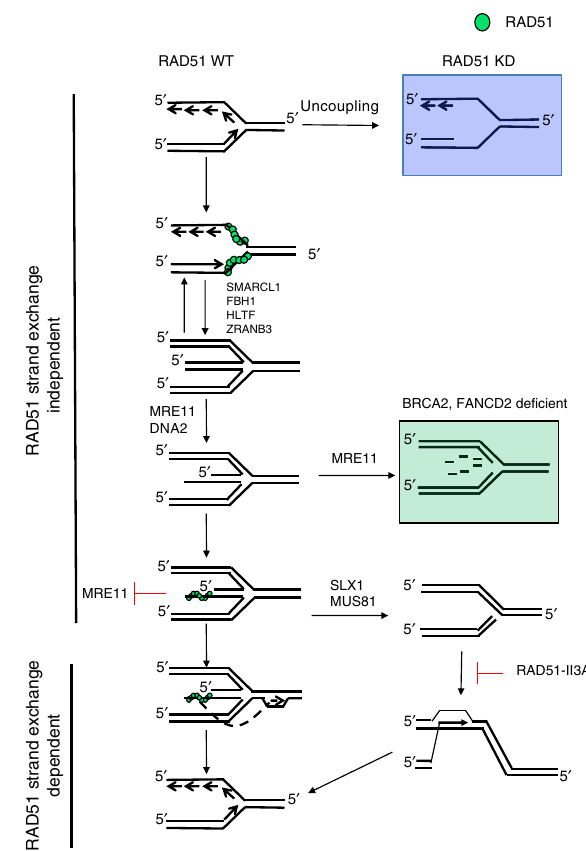
Fig. 6 Model depicting role of RAD51 at stalled replication forks. RAD51 binds to a stalled replication fork and stabilizes it by preventing extensive ssDNA formation. Proteins such as SMARCL1 and FBH1 promote replication fork regression resulting in the formation of the chicken foot structure. DNA2 resects the middle toe providing a substrate for RAD51 strand exchange-dependent fork restart. DNA2 also promotes degradation of nascent strands after fork regression in cells expressing hsRAD51-WT or hsRAD51-II3A (not depicted). In RAD51-depleted cells (RAD51 KD), the replication fork contains excess ssDNA due to uncoupling (Blue Box). hsRAD51-II3A is able to prevent MRE11-degradation by binding directly to the middle toe. hsRAD51-II3A is unable to restart the fork via strand exchange activity resulting in trapped replication intermediate that often consists of a one-ended DSB formed by MUS81-dependent cleavage of a reversed fork. The one-ended DSB formed requires RAD51 strand exchange activity to repair the break and reinstate the replication